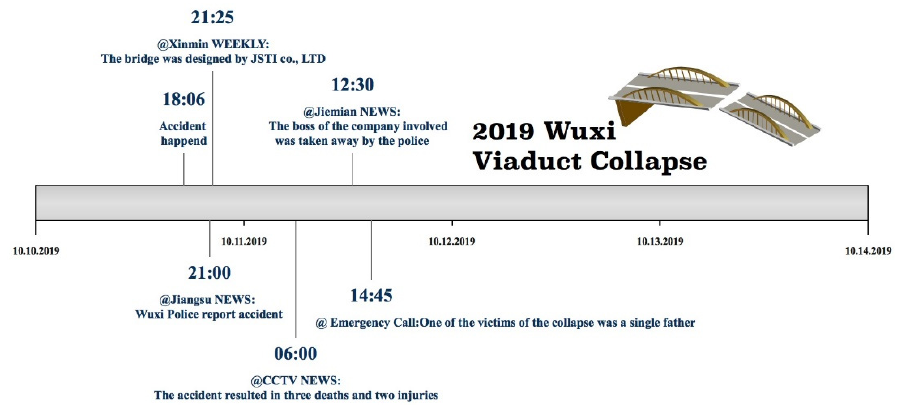
Figure 3. Important time nodes and developments in “2019 Wuxi Viaduct